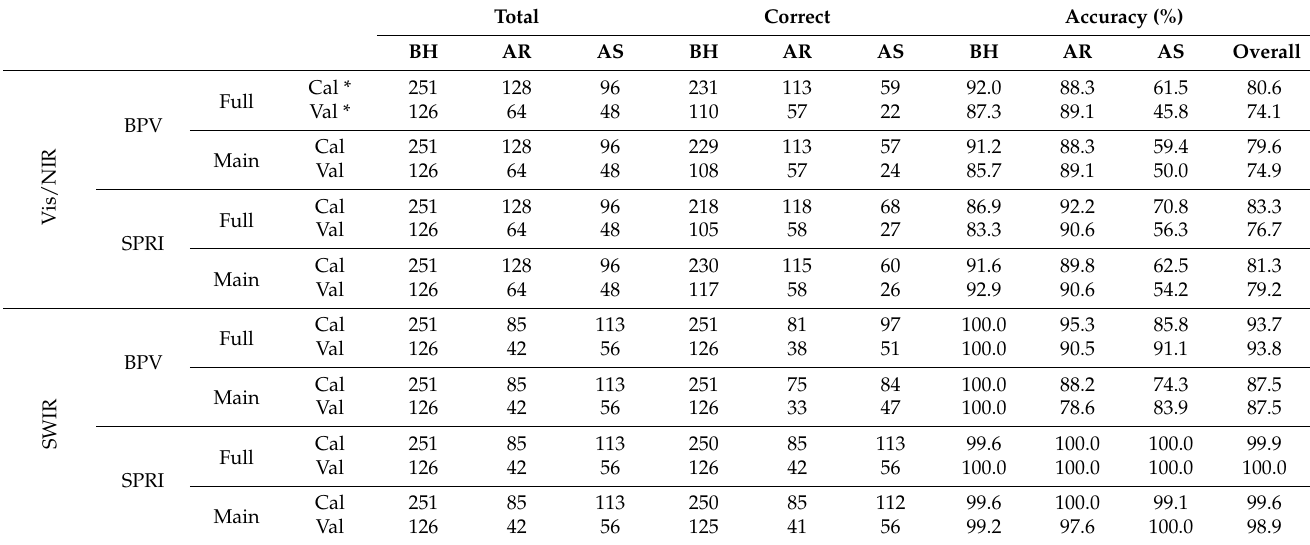
Table 1. Full spectrum of PLS-DA and main waveband extraction results of VIP–SPA ensemble analysis in the Vis/NIR and SWIR area.